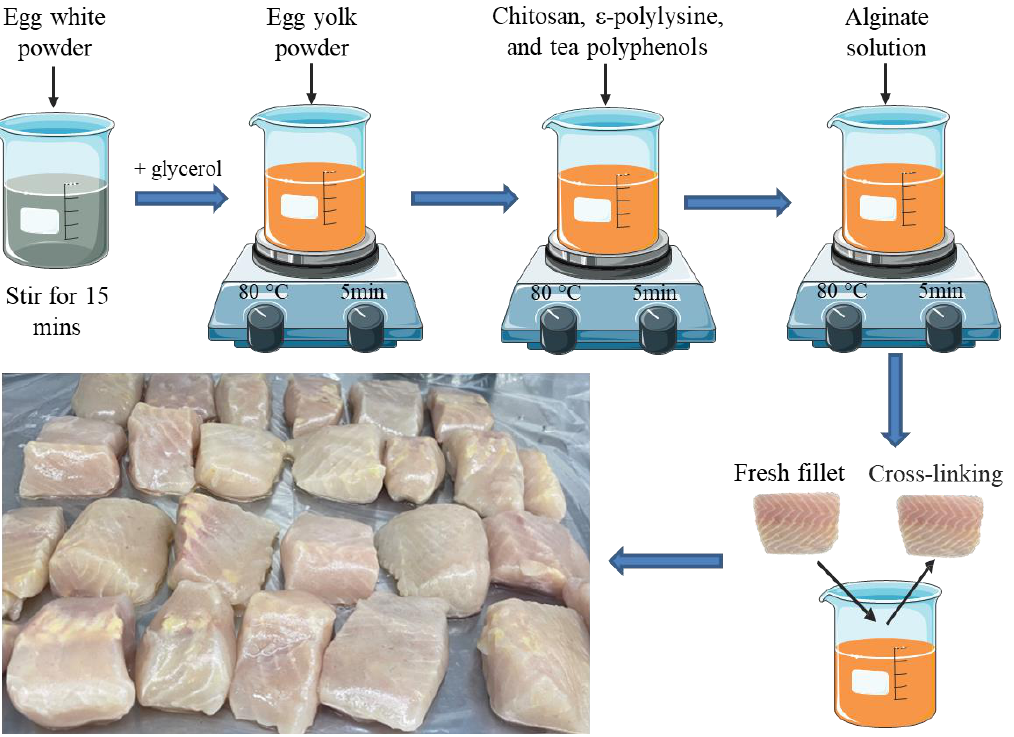
Figure 1. The schematic diagram of the experimental design.